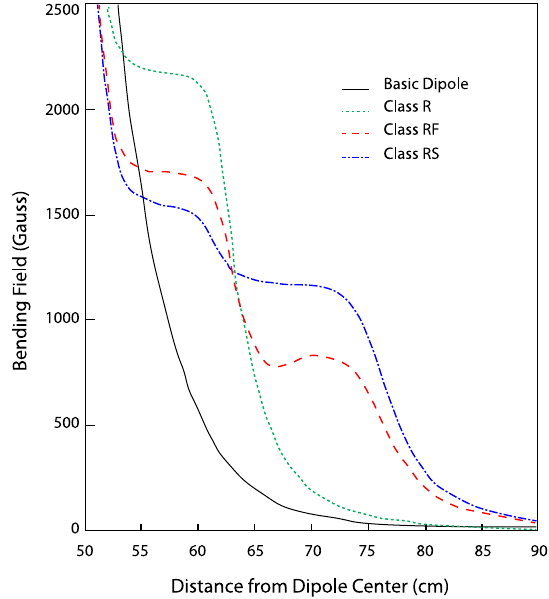
FIG. 6. Bending fields along the circular arc for the four models discussed above. The field values for the three classes of extensions have been normalized to give the same integral of BdL along the approximate beam path. For example, the larger bending field of Class-RS fringe field compared to the basic dipole is compensated by a slightly lower central